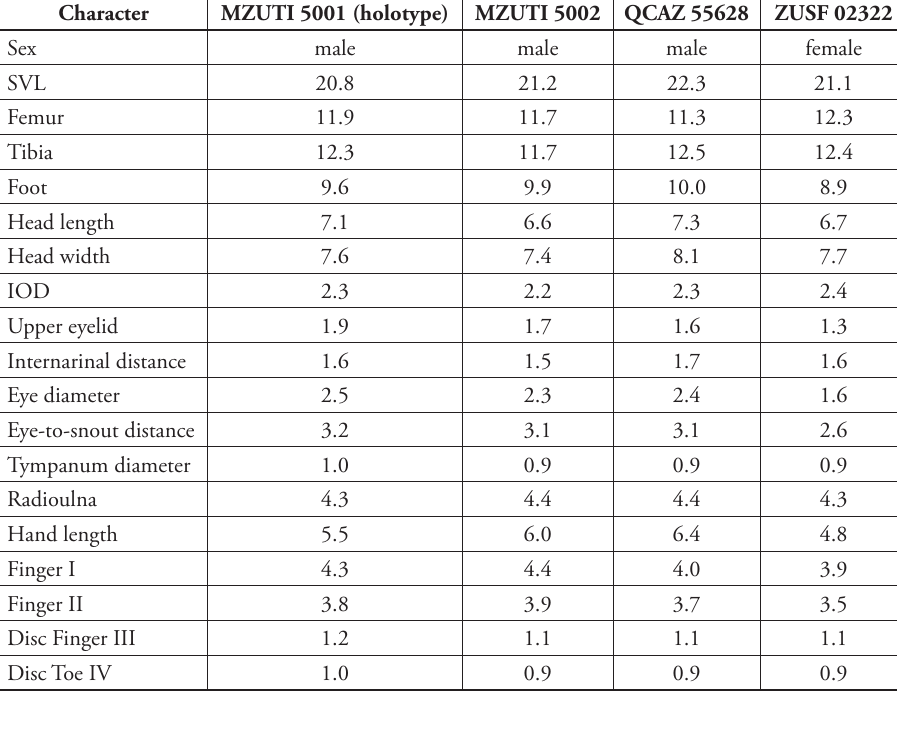
Table 2. Meristic variation of Hyalinobatrachium yaku sp. n. (in mm).